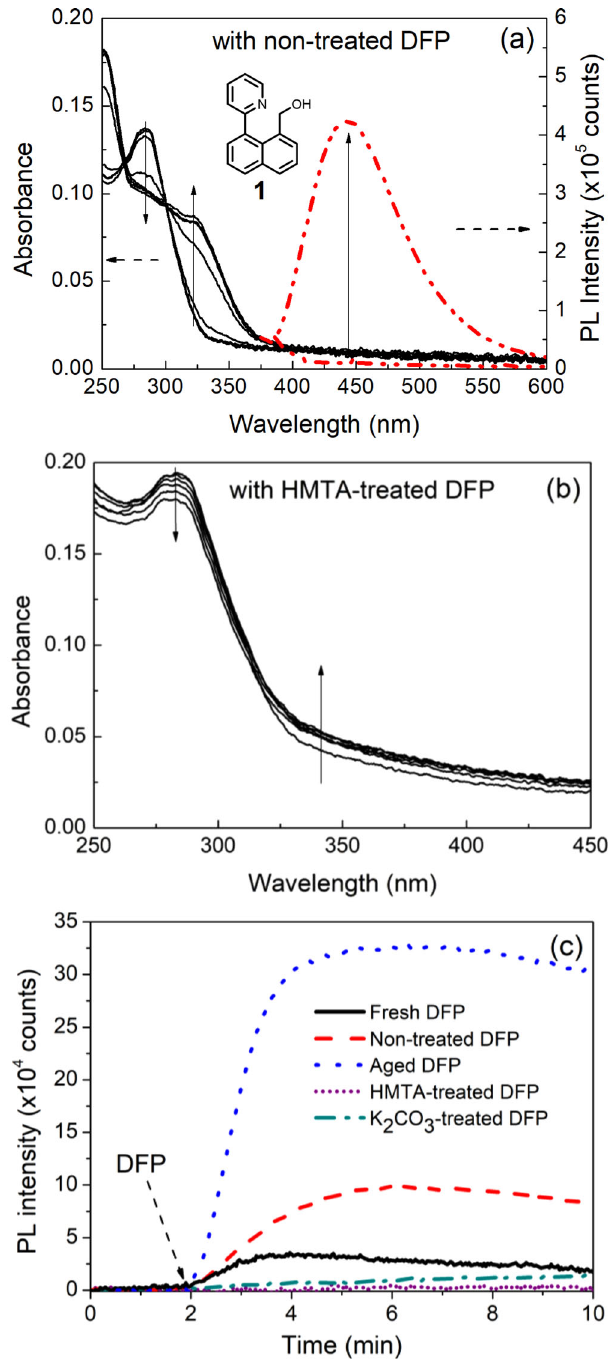
Fig. 5 Sensing results of compound 1 upon exposure to differently treated DFP. a UV – vis absorption and PL spectra (excitation wavelength = 365nm) of 10wt% 1 :cellulose acetate fi lms upon exposure to non-treated DFP (0 –